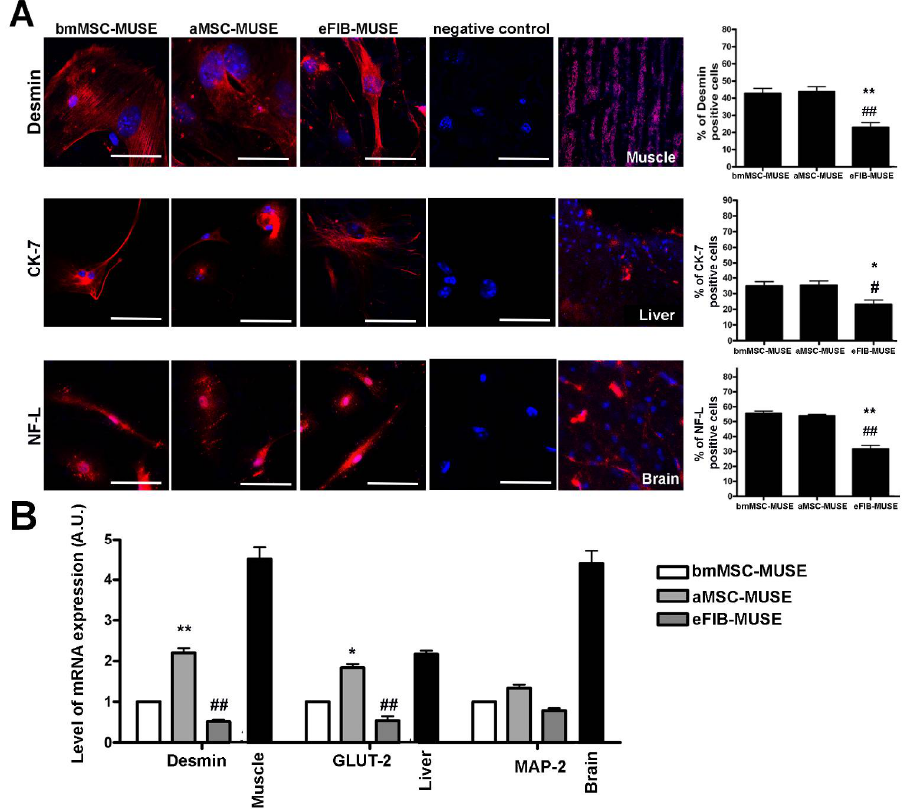
Figure 6. MUSE cells showed spontaneous meso/endo/ectodermal differentiation capacity. ( A ) Representative picture of ICC staining after spontaneous differentiation of MUSE cells. Desmin (red) was used as a mesodermal marker; muscle tissue was used as positive control. CK-7 (red) was used as endodermal marker; liver tissue was used as positive control. NF-L (red) was used as ectodermal marker; brain tissue was used as positive control. We performed ICC only with secondary antibodies, as reaction negative control. The nuclei were counterstained with DAPI (blue). The histograms show the percentage of Desmin, CK-7, and NF-L-positive cells. The data are expressed with standard deviation ( n = 5). ( B ) mRNA expression levels of meso/endo/ectodermal lineage markers. The histograms show the quantitative RT-PCR analysis of desmin (mesodermal marker), GLUT2 (endodermal marker), and MAP2 (ectodermal marker). The mRNA levels were normalized to GAPDH mRNA expression, which was selected as an internal control. Histograms show expression levels in the different MUSE cell, non-MUSE cell population, and tissues. Muscle, liver, and brain were used as reference tissues for mesodermal, endodermal, and ectodermal markers respectively. For each gene, the expression level of bmMSC-MUSE was set as the baseline (the arbitrary value is 1). All experimental data are represented as mean ± standard deviation (SD) of five independent replicates ( n = 5). We compared the three MUSE cells populations. The statistical differences among bmMSC-MUSE (first column) and the other MUSE cell populations are indicated with * (* p < 0.05, ** p < 0.01). The statistical differences among aMSC-MUSE (second column) and the other MUSE cell populations are indicated with # (# p < 0.05, ## p <